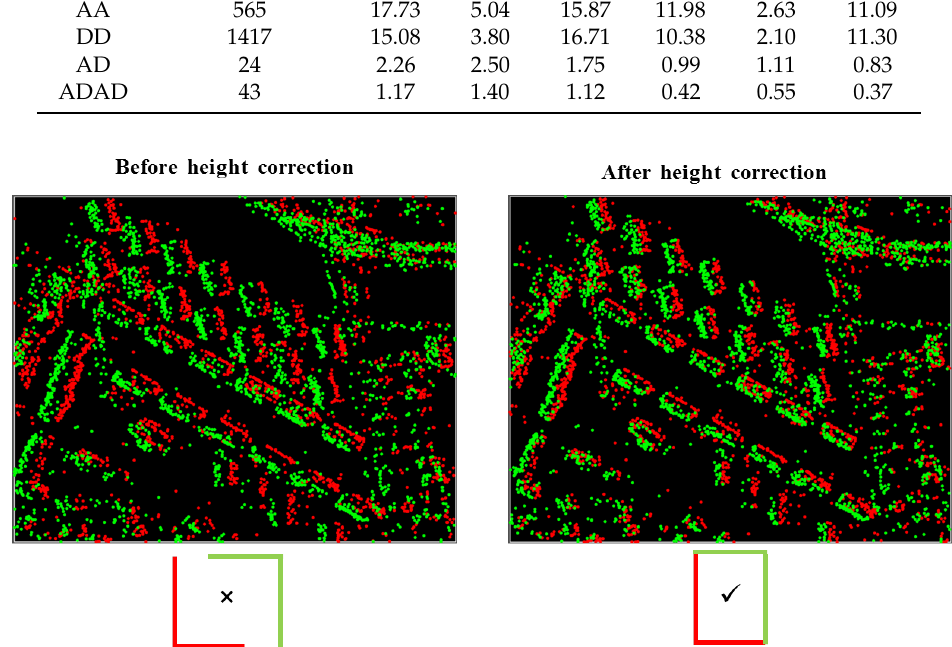
Figure 16. Demonstration of absolute localization of PSI point clouds obtained from an ascending and a descending orbit track of Oulu. The endpoints of buildings visible from each geometry match correctly with the endpoints from the opposing